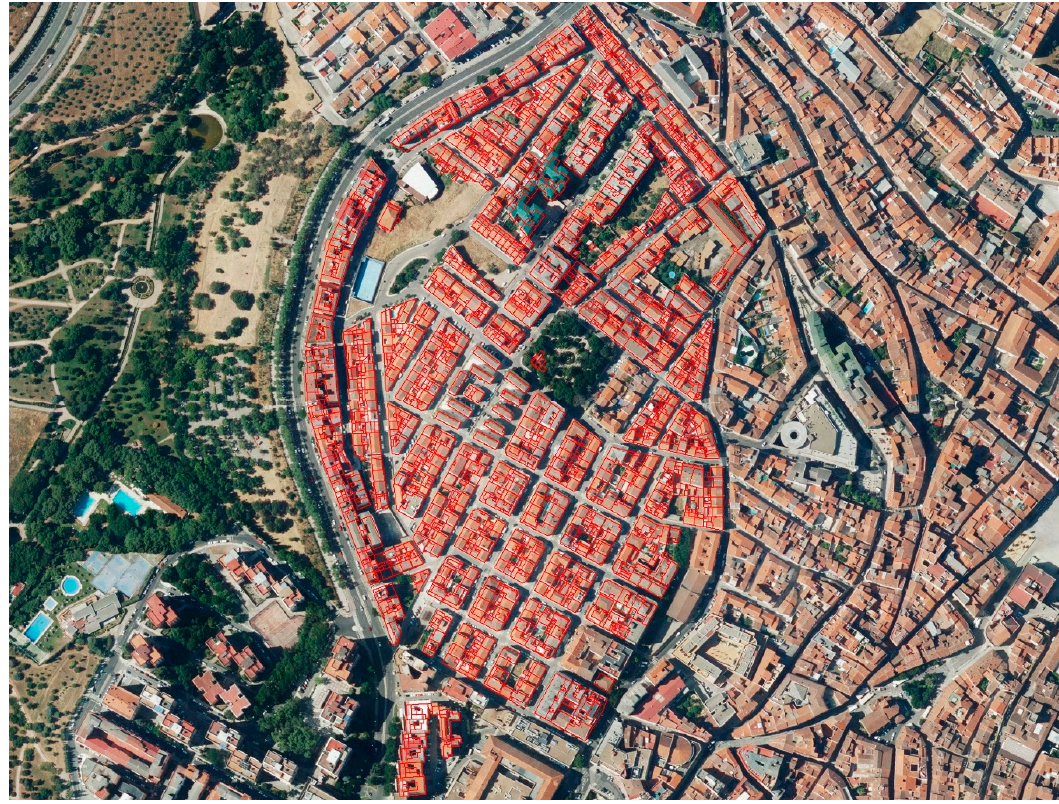
Figure 2. Vectors of the rooftops within a residential area in the city center (zone 1).